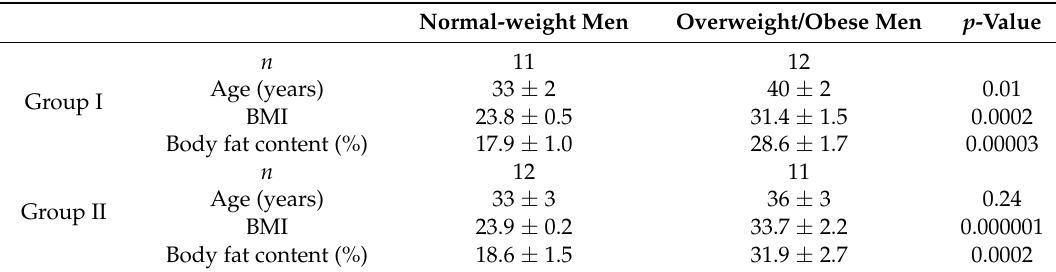
Table 1. The study population characteristic.